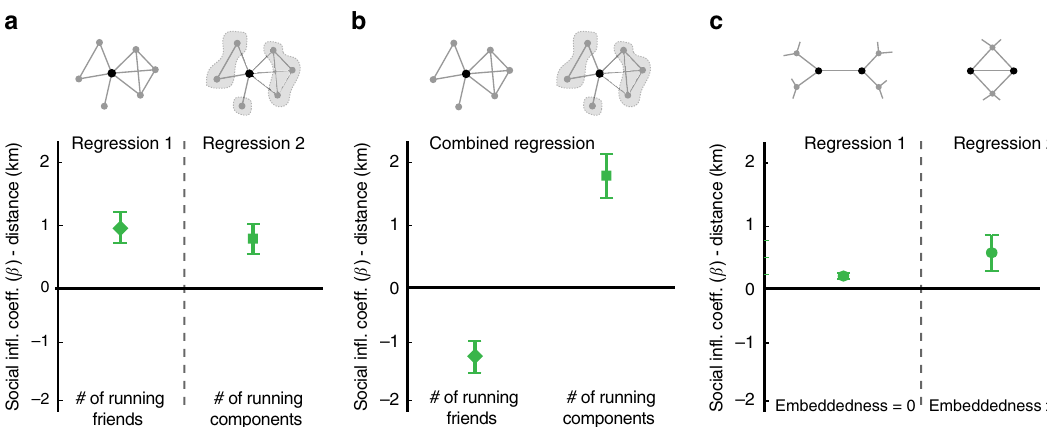
Figure 3 | Testing structural theories of networked contagion. The panels describe the structural correlates of social influence in the distance run (in km). Panel ( a ) estimates the social influence effects of the number of distinct friends that run and the number of distinct components of friends that run independently, in separate regressions (separated by the dotted line). Panel ( b ) directly compares, in the same regression, the number of distinct friends that run (supporting Complex Contagion theory) and the number of distinct network components of friends that run (supporting Structural Diversity theory) as structural moderators of social influence effects. The positive estimate for the number of distinct network components of friends that run and the negative estimate for the number of distinct friends that run, when both are analysed together in ( b ), supports the Structural Diversity theory. Panel ( c ) tests whether embedded dyadic relationships with mutual friends transmit influence more effectively than relationships with no mutual friends (supporting Embeddedness theory). The social influence coefficient estimated for embedded relationships (Regression 2) is statistically significantly greater than the social influence coefficient estimated for non-embedded relationships (Regression 1) ( t -statistic ¼ 2.45, N ¼ 10.7M). Bars are 95% confidence